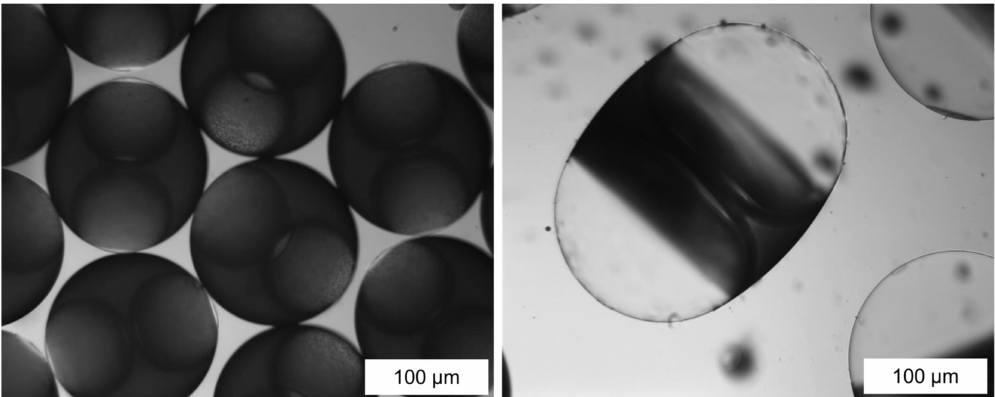
Figure 11. The same microfluidic double emulsion with two inner water droplets directly after production (left) and after 5 days (right). W1 / O / W2 phases consist of an aqueous 0.35 wt % NaCl solution, canola oil with PGPR, and of aqueous polyvinyl alcohol solution, respectively. After 5 days, water droplets are swollen due to osmotic swelling and the oil droplets deform. White bar: 100 µ